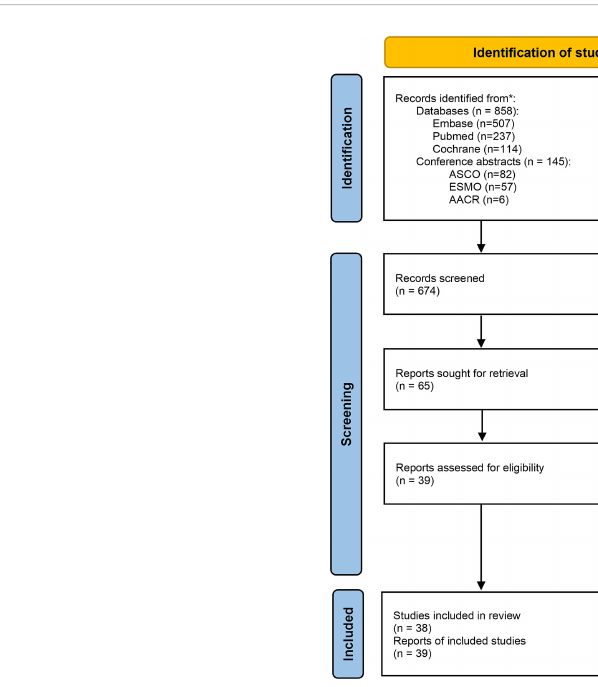
FIGURE 1 Flow chart of the selection process. *The literature search were performed up to July 14,